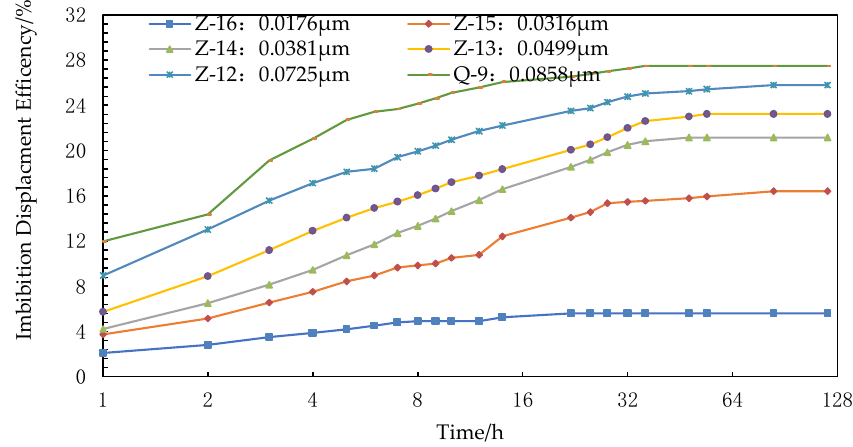
Figure 4. Displacement efficiency curve of imbibition for investigating the RQI.